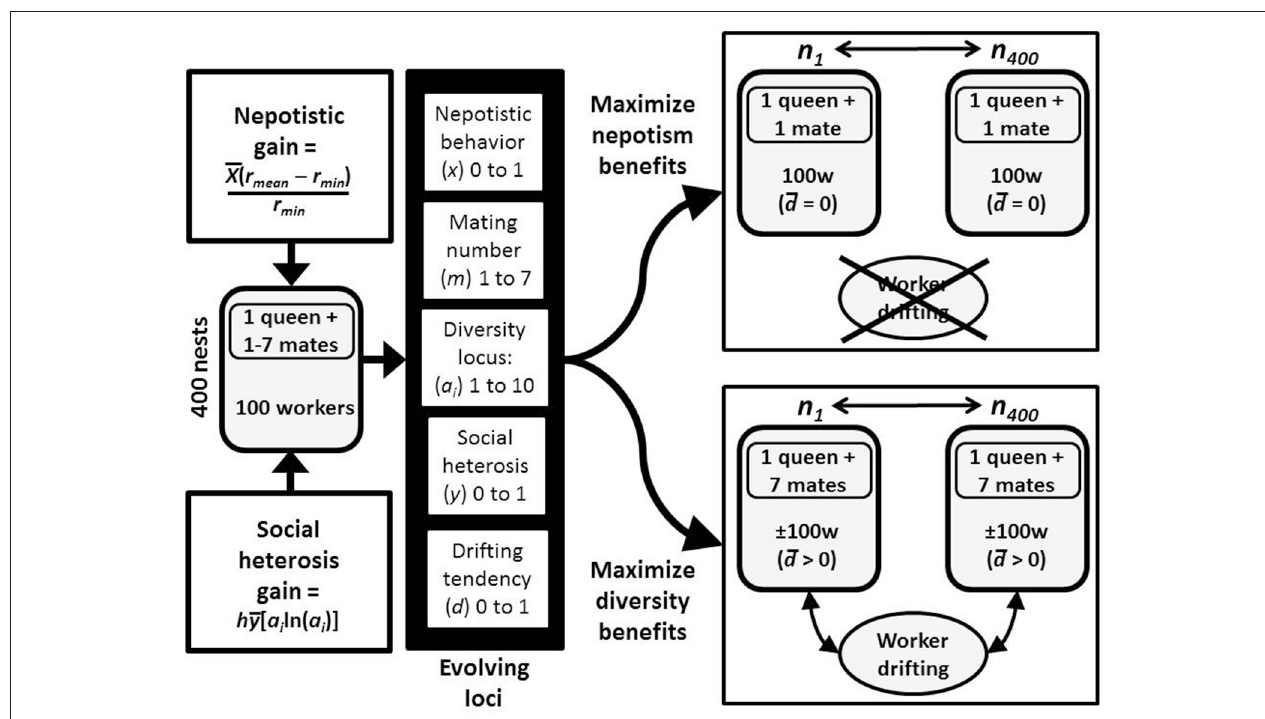
FIGURE 2 | Flowchart for the model and evolution by nepotism vs. social heterosis. In response to the availability of benefits from both nepotism and genetic diversity, there are 5 possible loci that can evolve. These are the number of times a queen will mate, a diversity locus that produces social heterosis, two loci for behaviors (unspecified in the model) that result in gaining the nepotistic or genetic diversity benefits, and a locus for a between-nest drifting predisposition. Because nepotism and social heterosis are likely to be mutually exclusive, populations will tend to evolve along one of the two